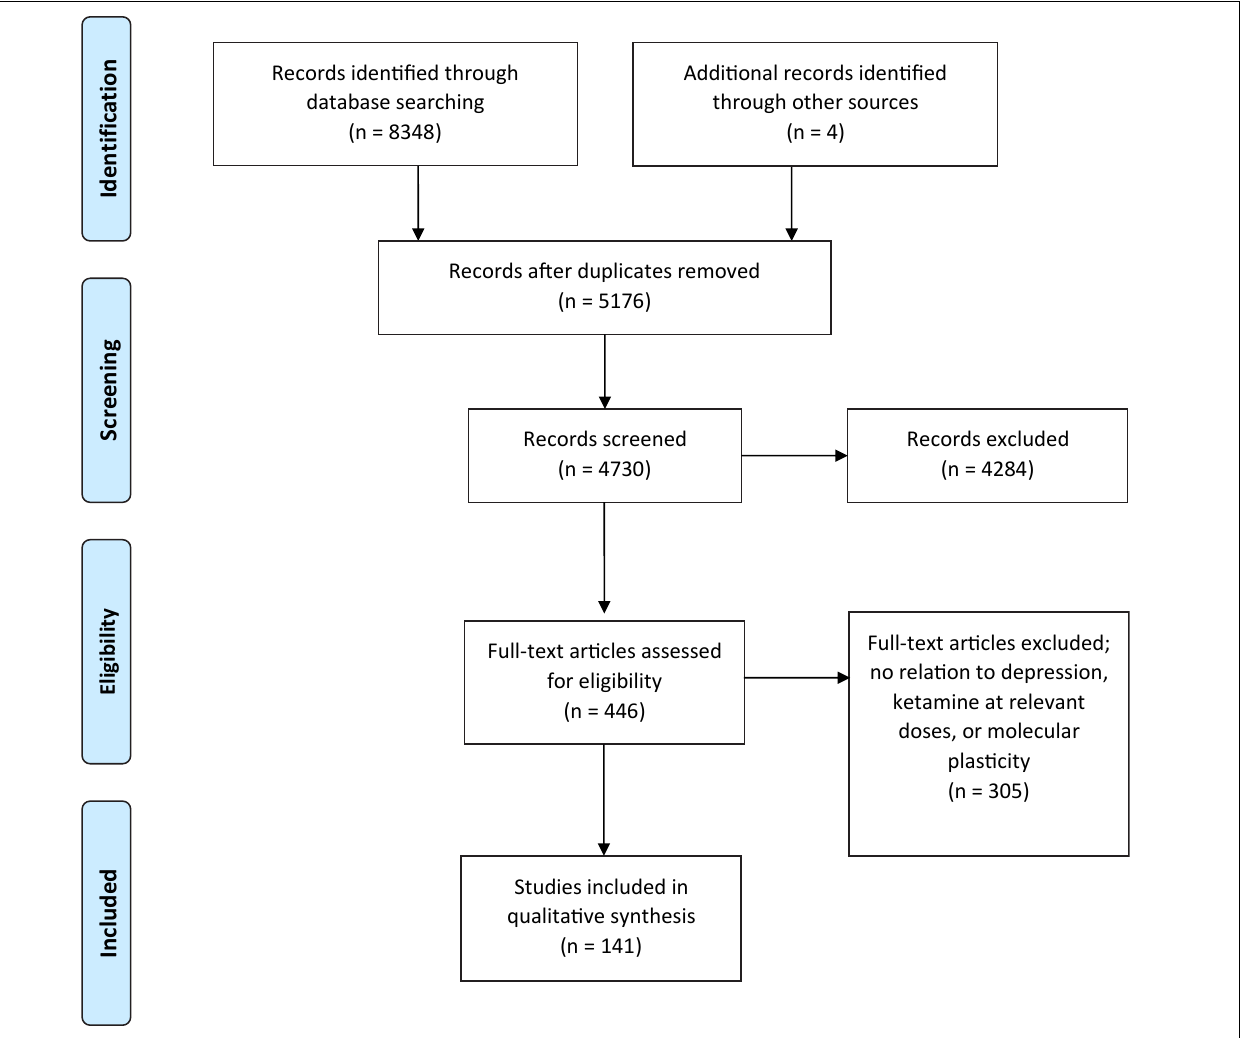
FIGURE 1 | Schematic representation of PRISMA methods utilized for this systematic